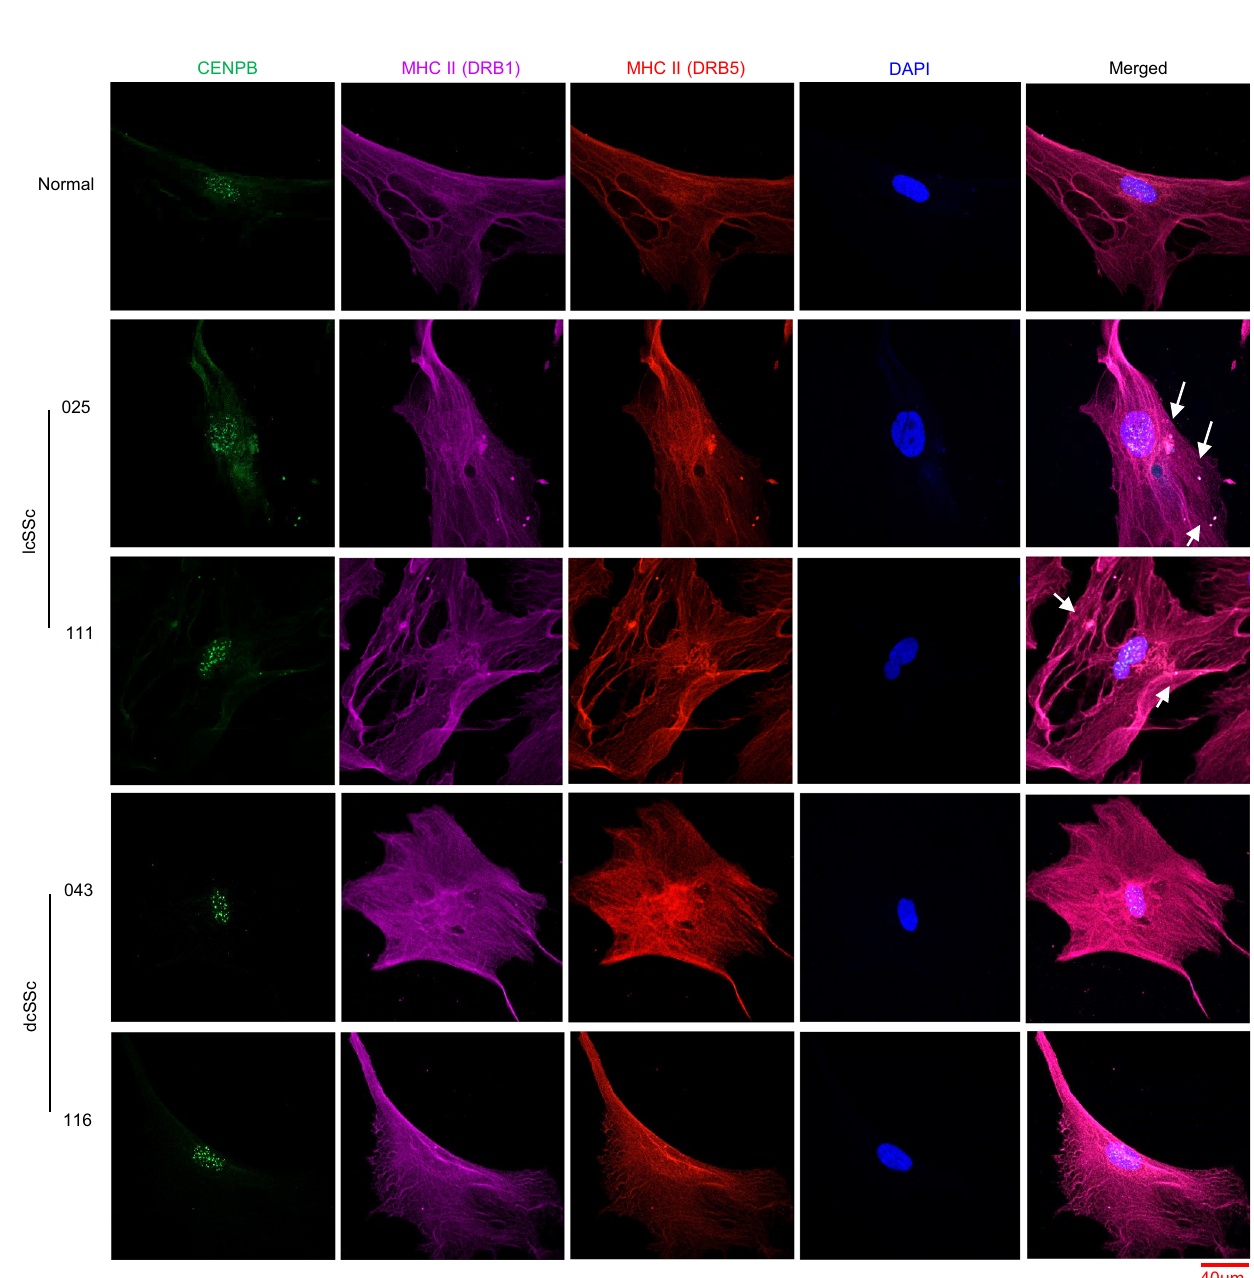
centromere proteins (arrows) in fi broblasts from ACA-positive lcSSc patients. Yel- low indicates colocalization of CENPA and CENPB. g Western blotting analysis of CENPA, GAPDH and H3K9Me3 in cytoplasmic and chromatin fractions from SSc fi broblasts grown in the presence of colchicine. GAPDH (cytoplasmic) and H3K9Me3(chromatin)con fi rmed the speci fi city andpurityof the fractions.CENPA was detected mostly in nuclear chromatin fractions as expected but was found leaked into the cytoplasmic fraction in lcSSc patient 025, who has ACAs. Patients 043 and 116 with dcSSc are seronegative for ACAs. A faint band is seen in the cytoplasmic fraction in patient 043. A more quantitative description of the data is found in Supplementary Table